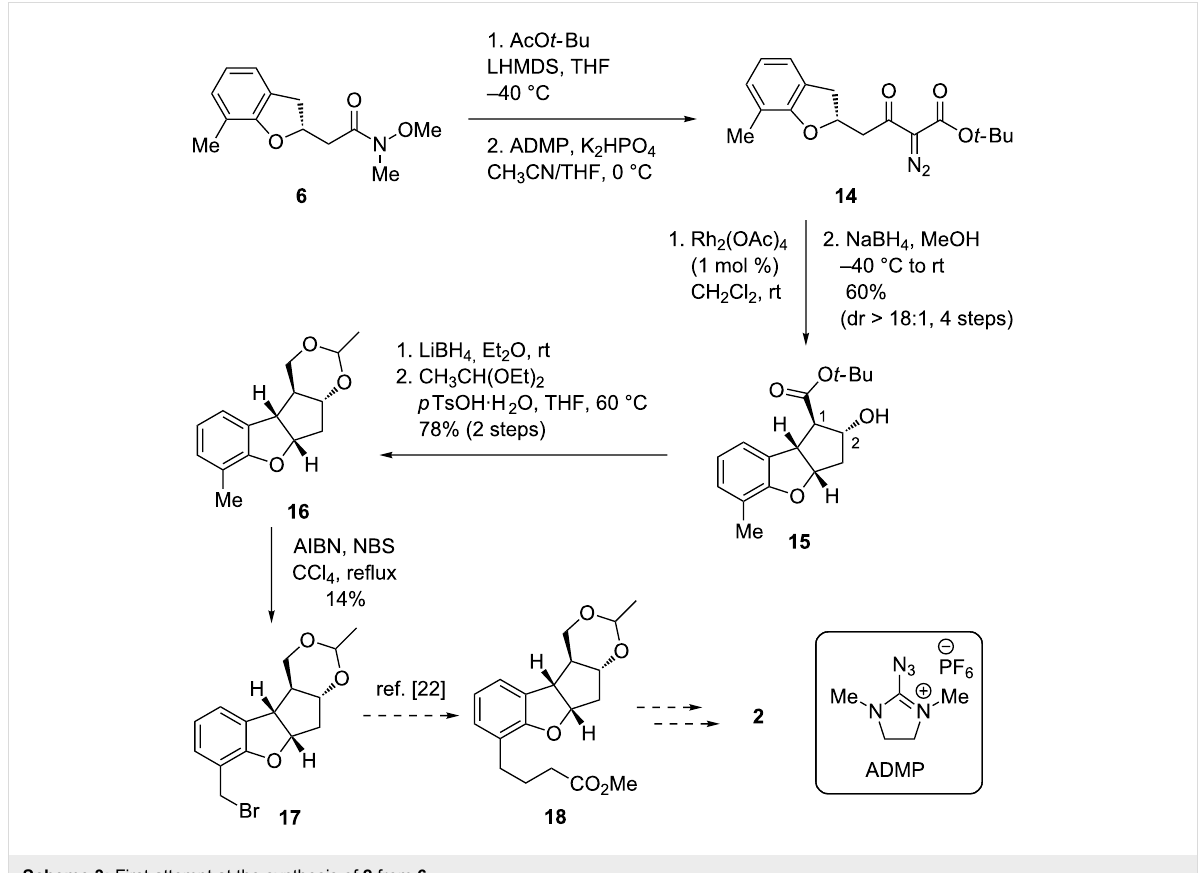
Scheme 3: First attempt at the synthesis of 2 from 6